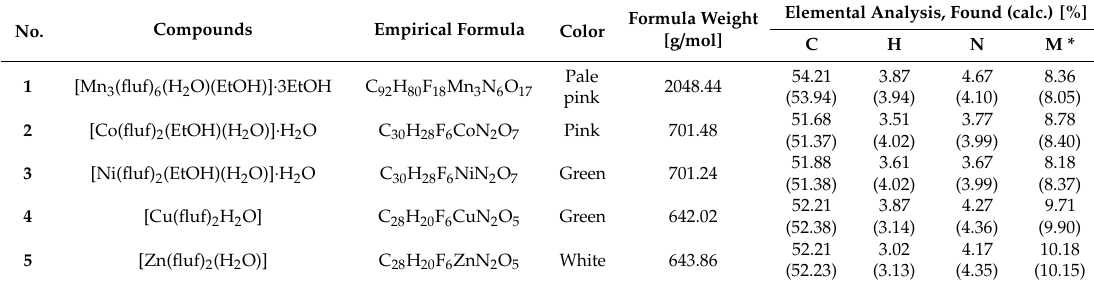
Table 1. Analytical data for 1 – 5 .